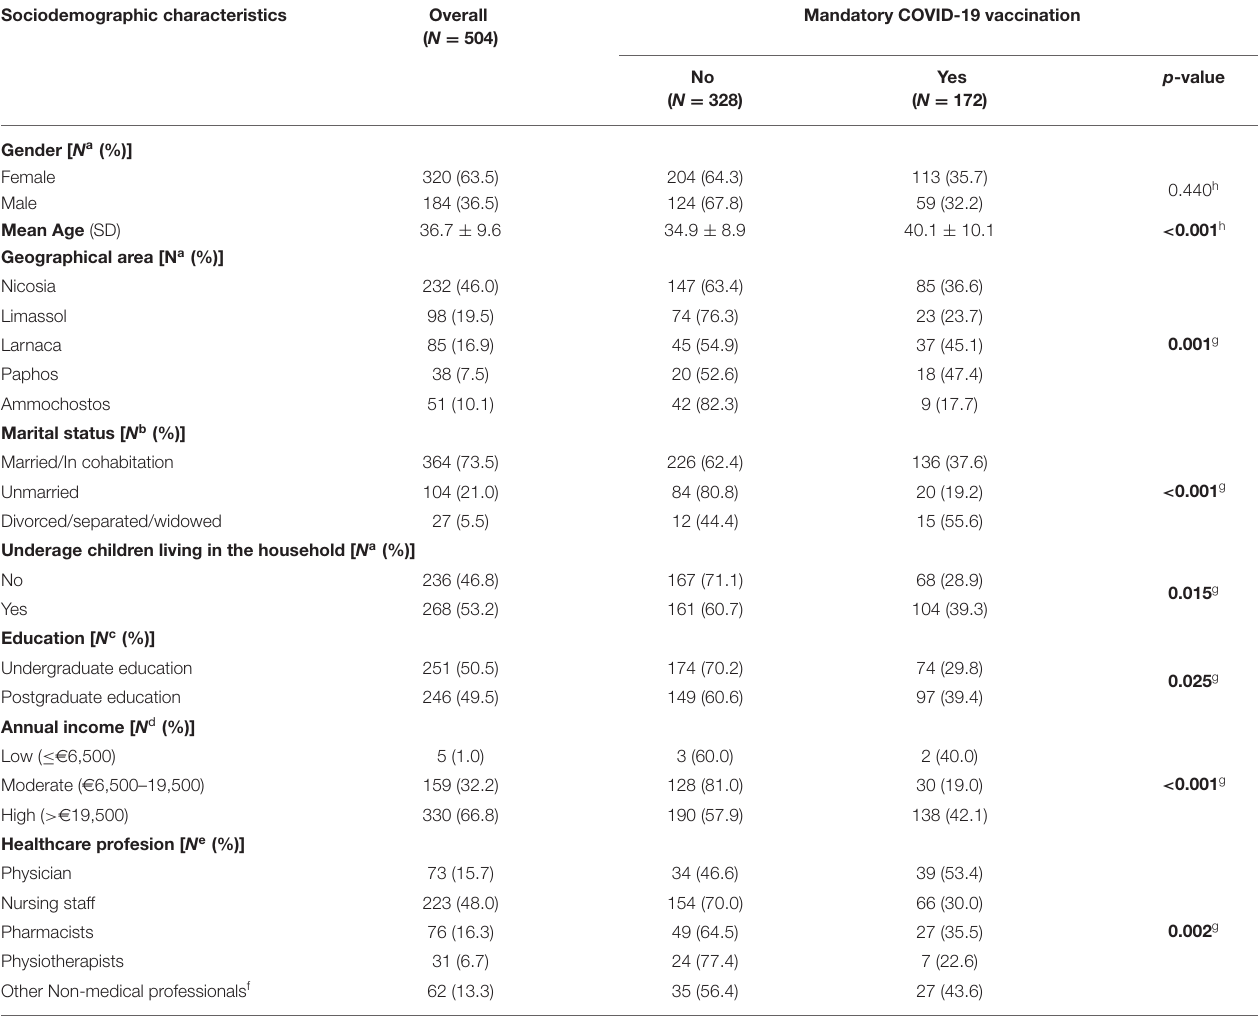
TABLE 1 | Sociodemographic characteristics of participants, overall and by mandatory vaccination support. Sociodemographic